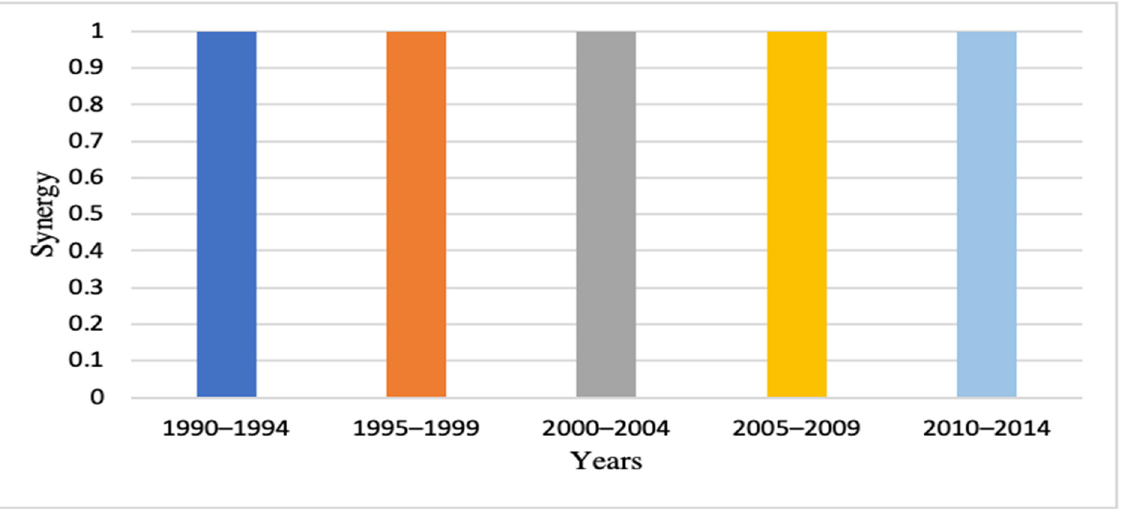
Figure 10. Synergy: GHG emission (CO 2 ) from energy sector (Industrial, Transport and Others) and per capita energy (Final) consumption.